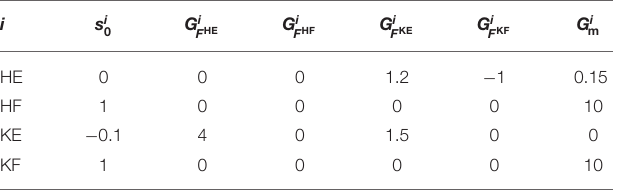
TABLE 1 | Values of the reflex circuit parameters in Equation (9).